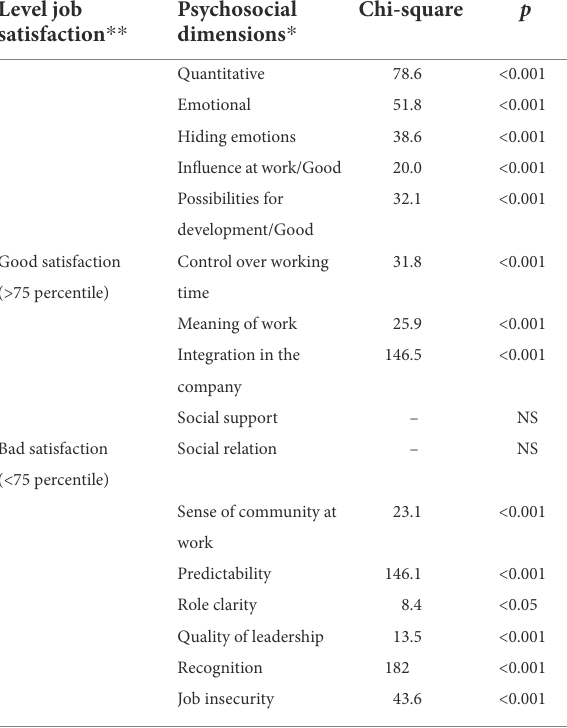
TABLE 4 Multivariate analysis adjusted by Odds Ratio (OR) and 95% confidence intervals for positive and negative psychosocial factors and the level of job